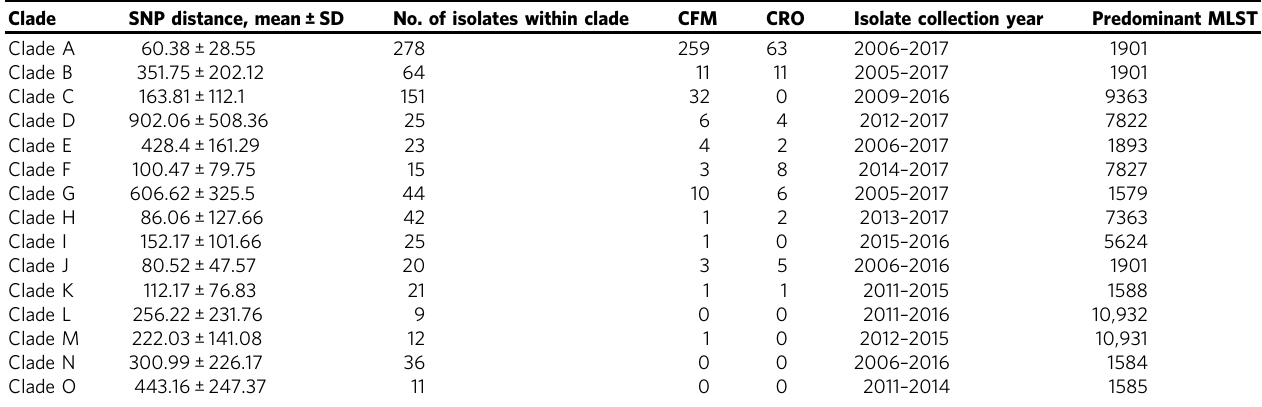
Table 1 Summary of clades identi fi ed in dataset including intra-clade single nucleotide polymorphisms (SNP) distances, total counts of isolates and those with elevated ce fi xime (CFM) or ceftriaxone (CRO) minimum inhibitory concentrations (MICs), collection year, and predominant multi-locus sequence type